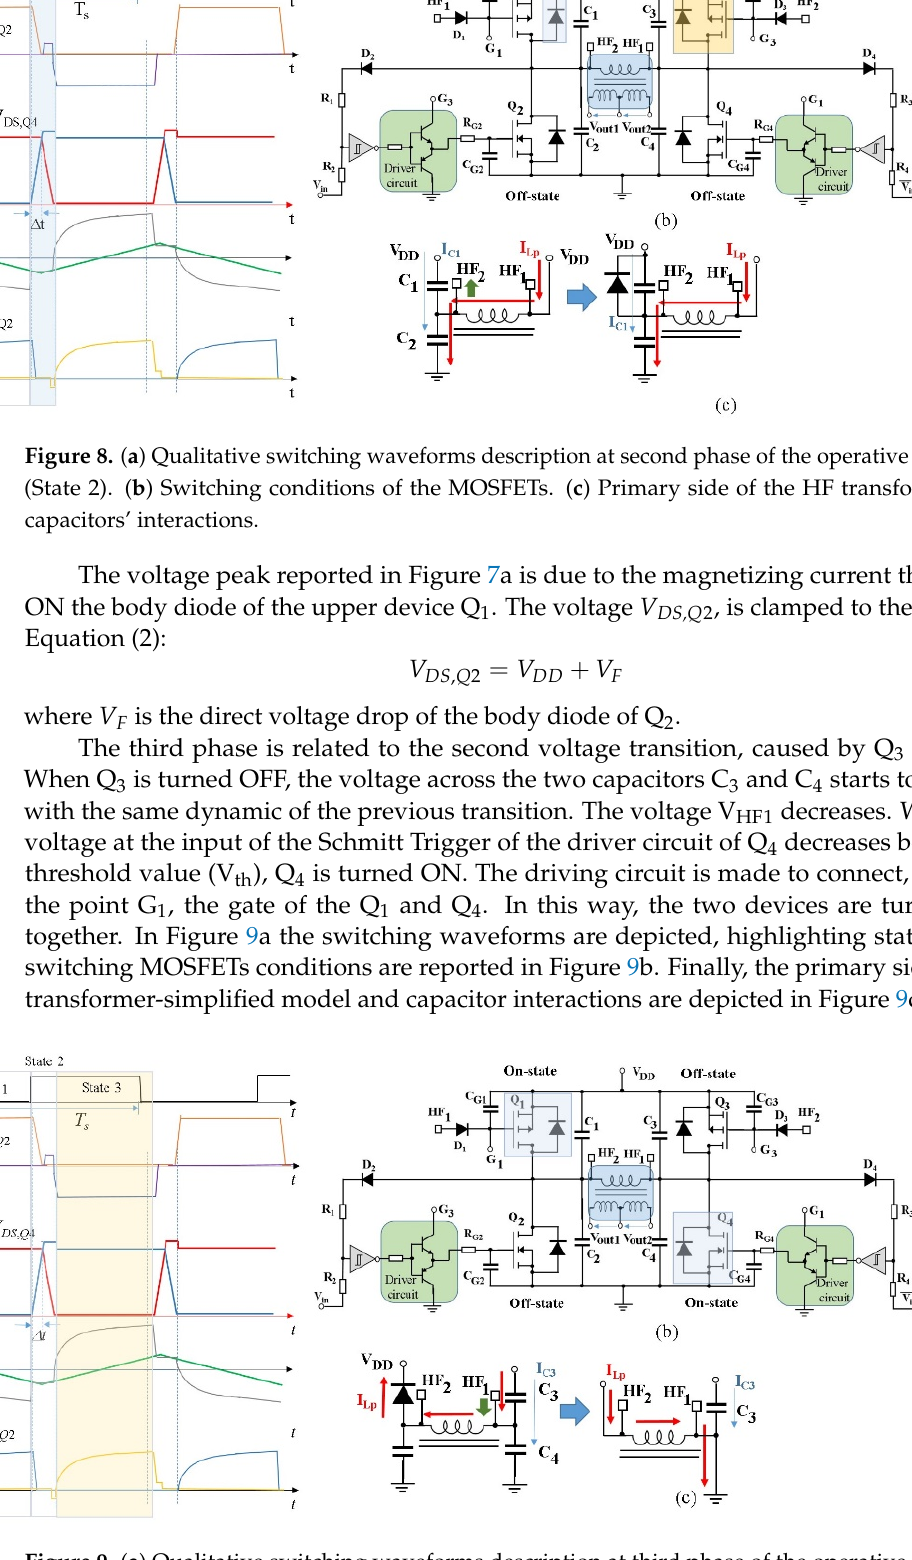
Figure 8. ( a ) Qualitative switching waveforms description at second phase of the operative condition (State 2). ( b ) Switching conditions of the MOSFETs. ( c ) Primary side of the HF transformer and capacitors’ interactions.